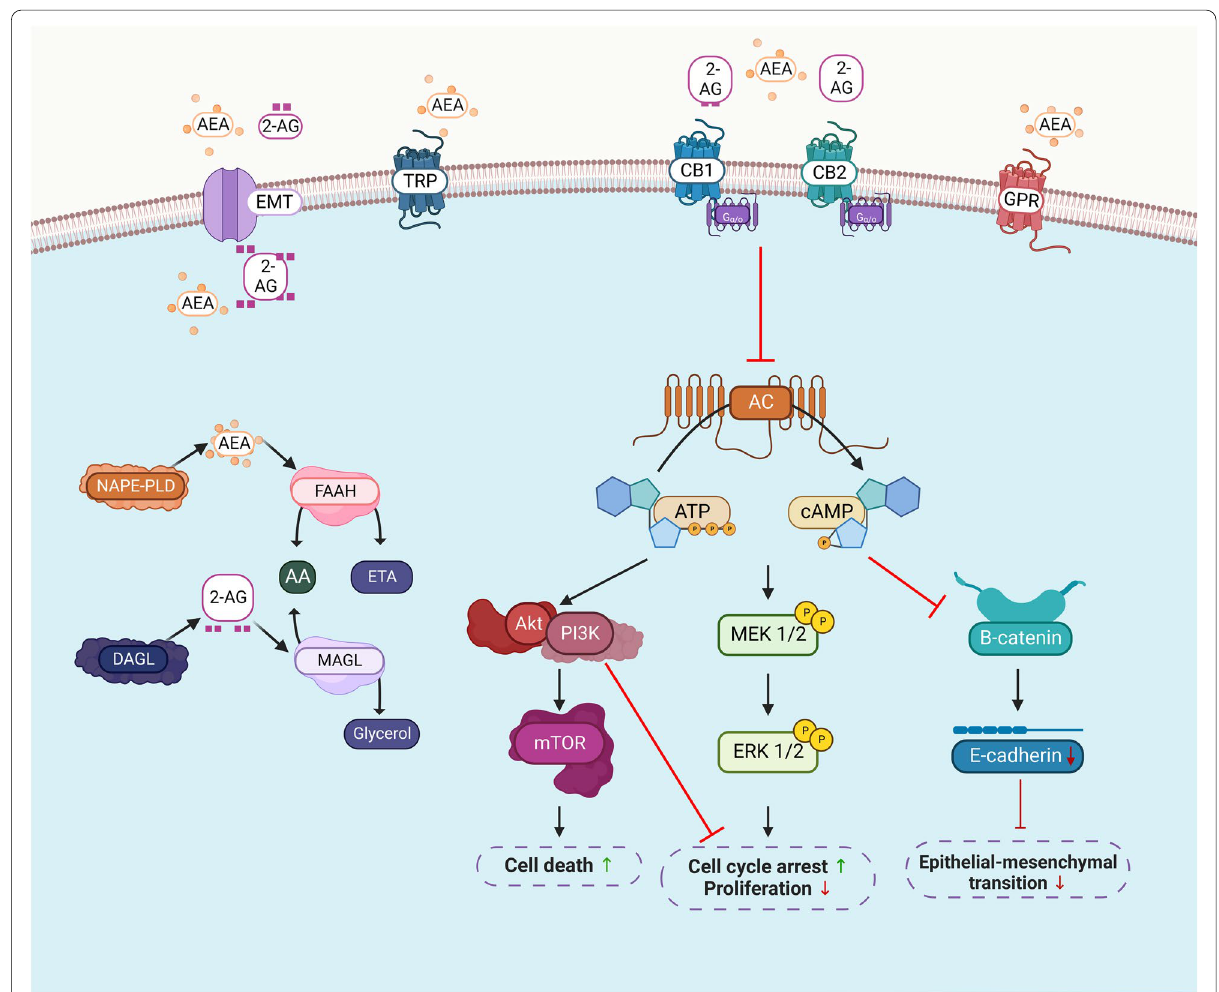
Fig. 2 The endocannabinoid system signaling cascade. Arachidonoylethanolamine (AEA) and 2-arachidonoylglycerol (2-AG) are biosynthesized by N-acylphosphatidylethanolamine phospholipase D (NAPE-PLD) and diacylglycerol lipase (DAGL), respectively. Fatty acid amide hydrolase (FAAH) and MAGL are the metabolizing enzymes that degrade AEA to produce arachidonic acid (AA) and ethanolamine (ETA), and 2-AG to AA and glycerol. AEA and 2-AG are transported in and out of a cell through the putative endocannabinoid membrane transporters (EMTs). AEA and 2-AG bind to G protein-coupled receptors (GRPs), such as cannabinoid receptors 1 (CB1) and 2 (CB2), at varying affinities and to a lesser extent with the orphan GPR and transient receptor potential (TRP) channels. The endocannabinoid system (ECS) mainly targets the protein kinase A (PKA) signaling cascade via inhibition of adenylyl cyclase (AC)-cyclic adenosine monophosphate (AMP) that has direct inhibitory effects on β-catenin which affects epithelial-mesenchymal transition. Activation of the mitogen-activated protein kinase signaling cascades, such as extracellular signal-regulated kinase ½ (ERK ½), protein kinase B or Akt, phosphatidylinositol-3-kinase (PI3K), mitogen-activated protein kinase (MEK1/2), and mammalian target of rapamycin (mTOR), is involved in cellular processes such as autophagy, apoptosis, cell cycle, and